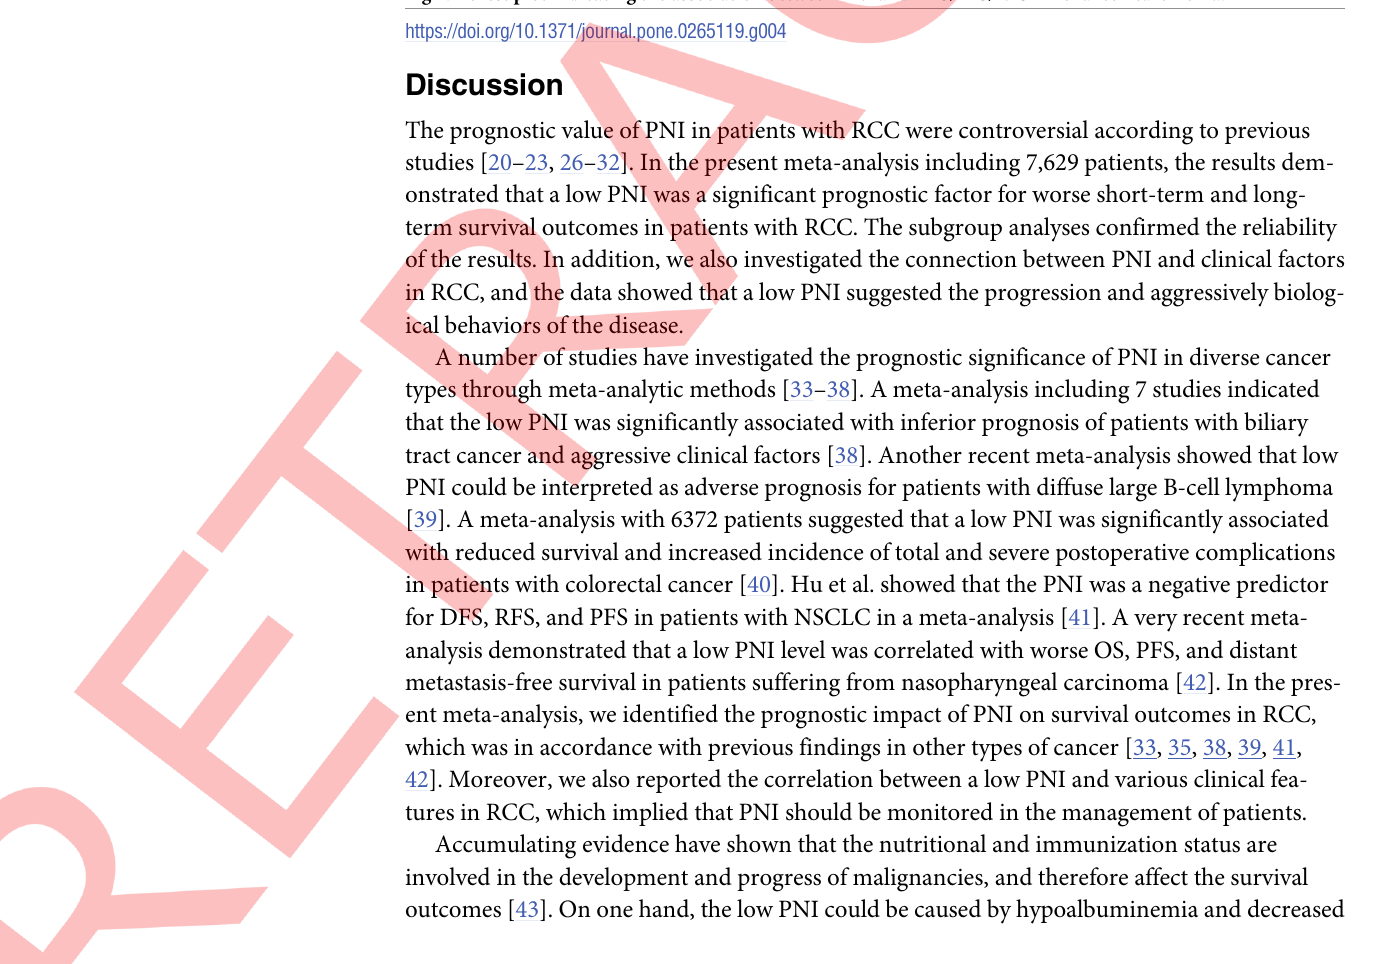
Fig 4. Forest plot indicating the association between PNI and DFS/PFS/RFS in renal cell